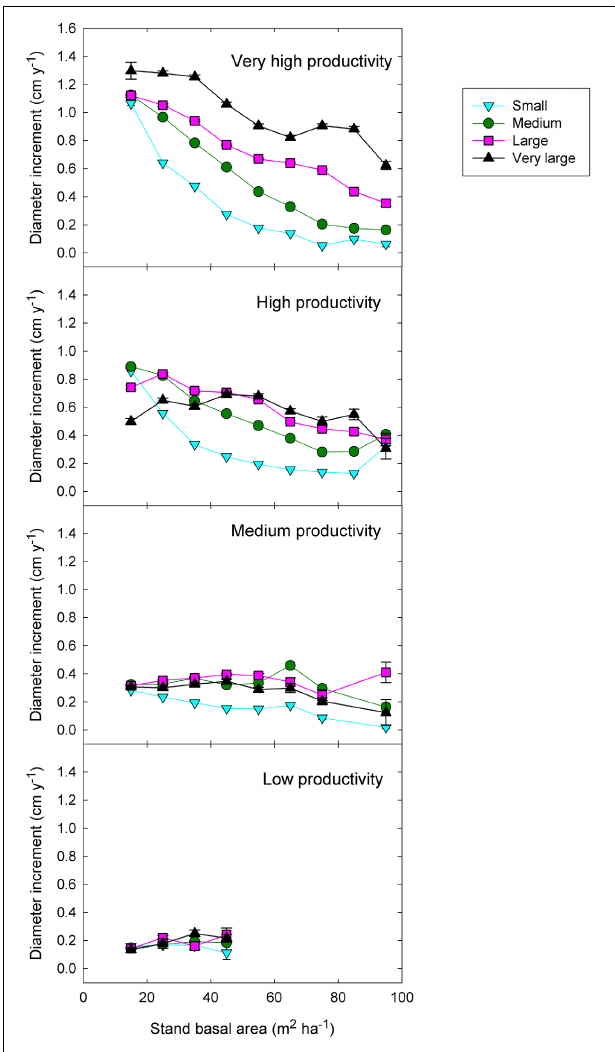
FIGURE 6 | Eucalypt diameter growth in relation to stand basal area, tree size, and climatic productivity category. (This is analogous to the left-hand graphs in Figure 7 , except that stand BA has been substituted for relative basal